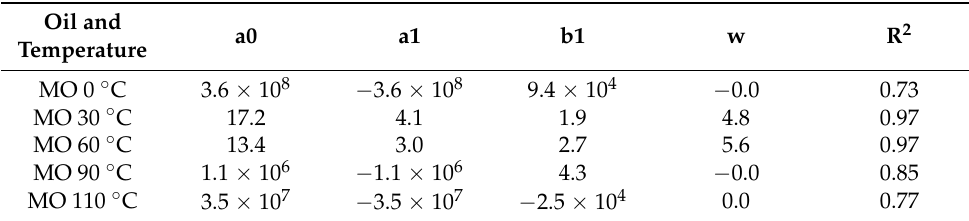
Table 7. Factors associated with Fourier distribution for MO with 95% confidence.